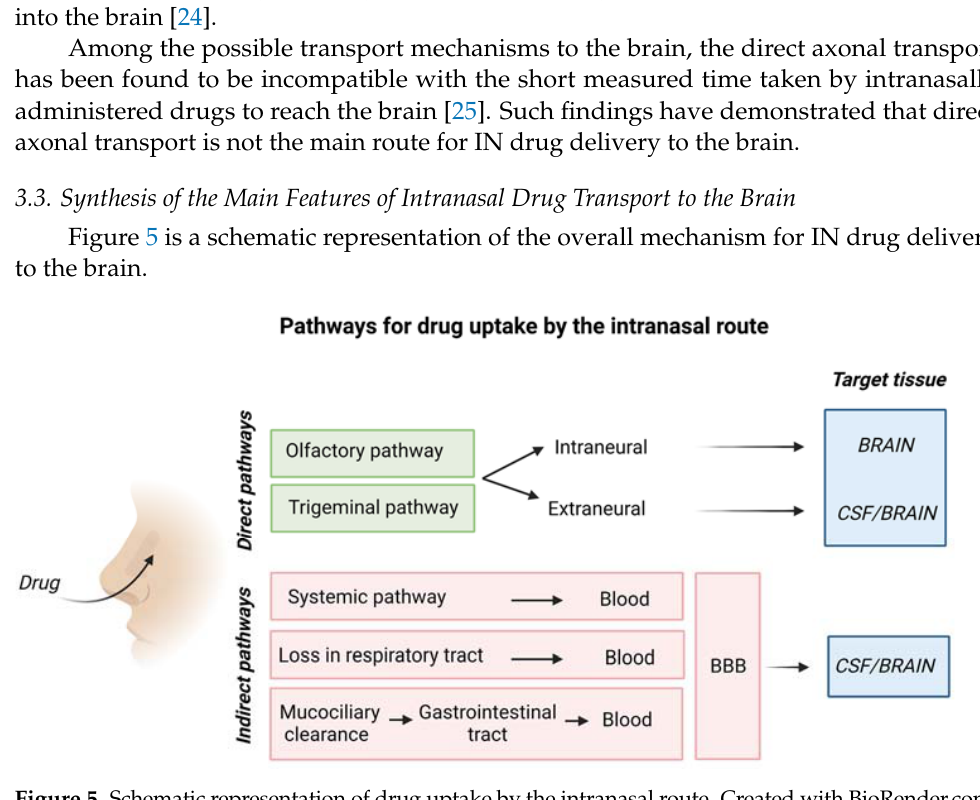
Figure 5. Schematic representation of drug uptake by the intranasal route. Created with BioRen ‐ der.com.